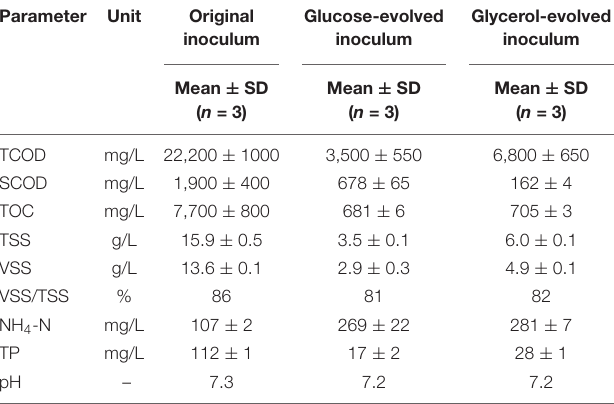
TABLE 1 | Physicochemical characterization of the original anaerobic inoculum used for the experiments of glucose and glycerol conversion under elevated pCO 2 and evolved inoculum after adaptive laboratory evolution (ALE) using glucose and glycerol (1 g COD L − 1 ) at T = 35 ◦ C, initial pCO 2 = 0.3 bar and initial pH in the range